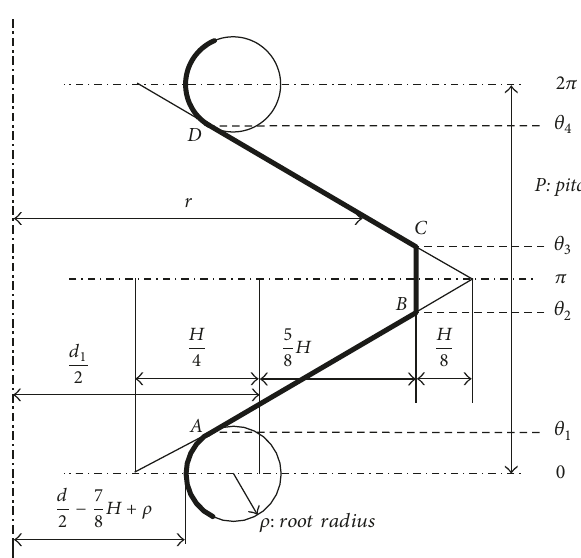
Figure 3: The cross-section profile along the bolt axis.